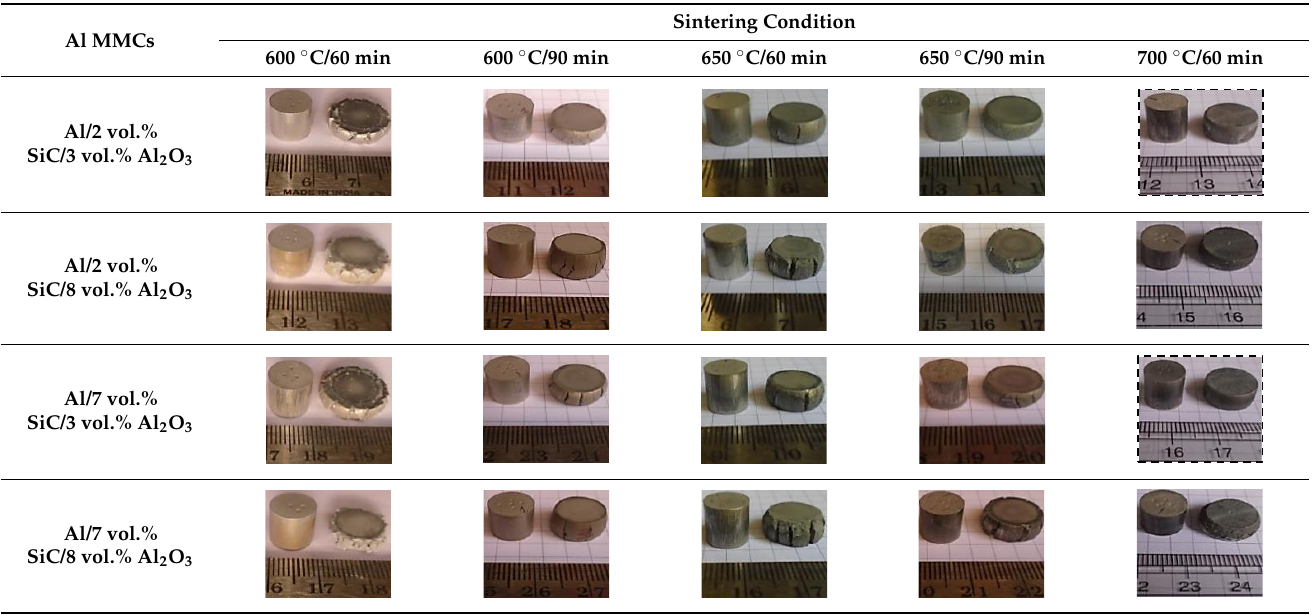
the circumference was perpendicular to the compression loading, indicating a brittle frac- Table 3. Deformation of the aluminum matrix composites (AMCs) following various sintering con- Table 3. Deformation of the aluminum matrix composites (AMCs) following various sintering con- Table 3. Deformation of the aluminum matrix composites (AMCs) following various sintering con- Table 3. Deformation of the aluminum matrix composites (AMCs) following various sintering con- Table 3. Deformation of the aluminum matrix composites (AMCs) following various sintering con- ture. ditions. ditions. ditions. ditions. Table 3. Deformation of the aluminum matrix composites (AMCs) following various sintering con- Table 3. Deformation of the aluminum matrix composites (AMCs) following various sintering con- Table 3. Deformation of the aluminum matrix composites (AMCs) following various sintering con- Table 3. Deformation of the aluminum matrix composites (AMCs) following various sintering con- Table 3. Deformation of the aluminum matrix composites (AMCs) following various sintering con- ditions. ditions. ditions. ditions. ditions. Table 3. Deformation of the aluminum matrix composites (AMCs) following various sintering con- Table 3. Deformation of the aluminum matrix composites (AMCs) following various sintering con- Table 3. Deformation of the aluminum matrix composites (AMCs) following various sintering con- Table 3. Deformation of the aluminum matrix composites (AMCs) following various sintering con- Table 3. Deformation of the aluminum matrix composites (AMCs) following various sintering con- Table 3. Deformation of the aluminum matrix composites (AMCs) following various sintering ditions. ditions. ditions. ditions. ditions. conditions.